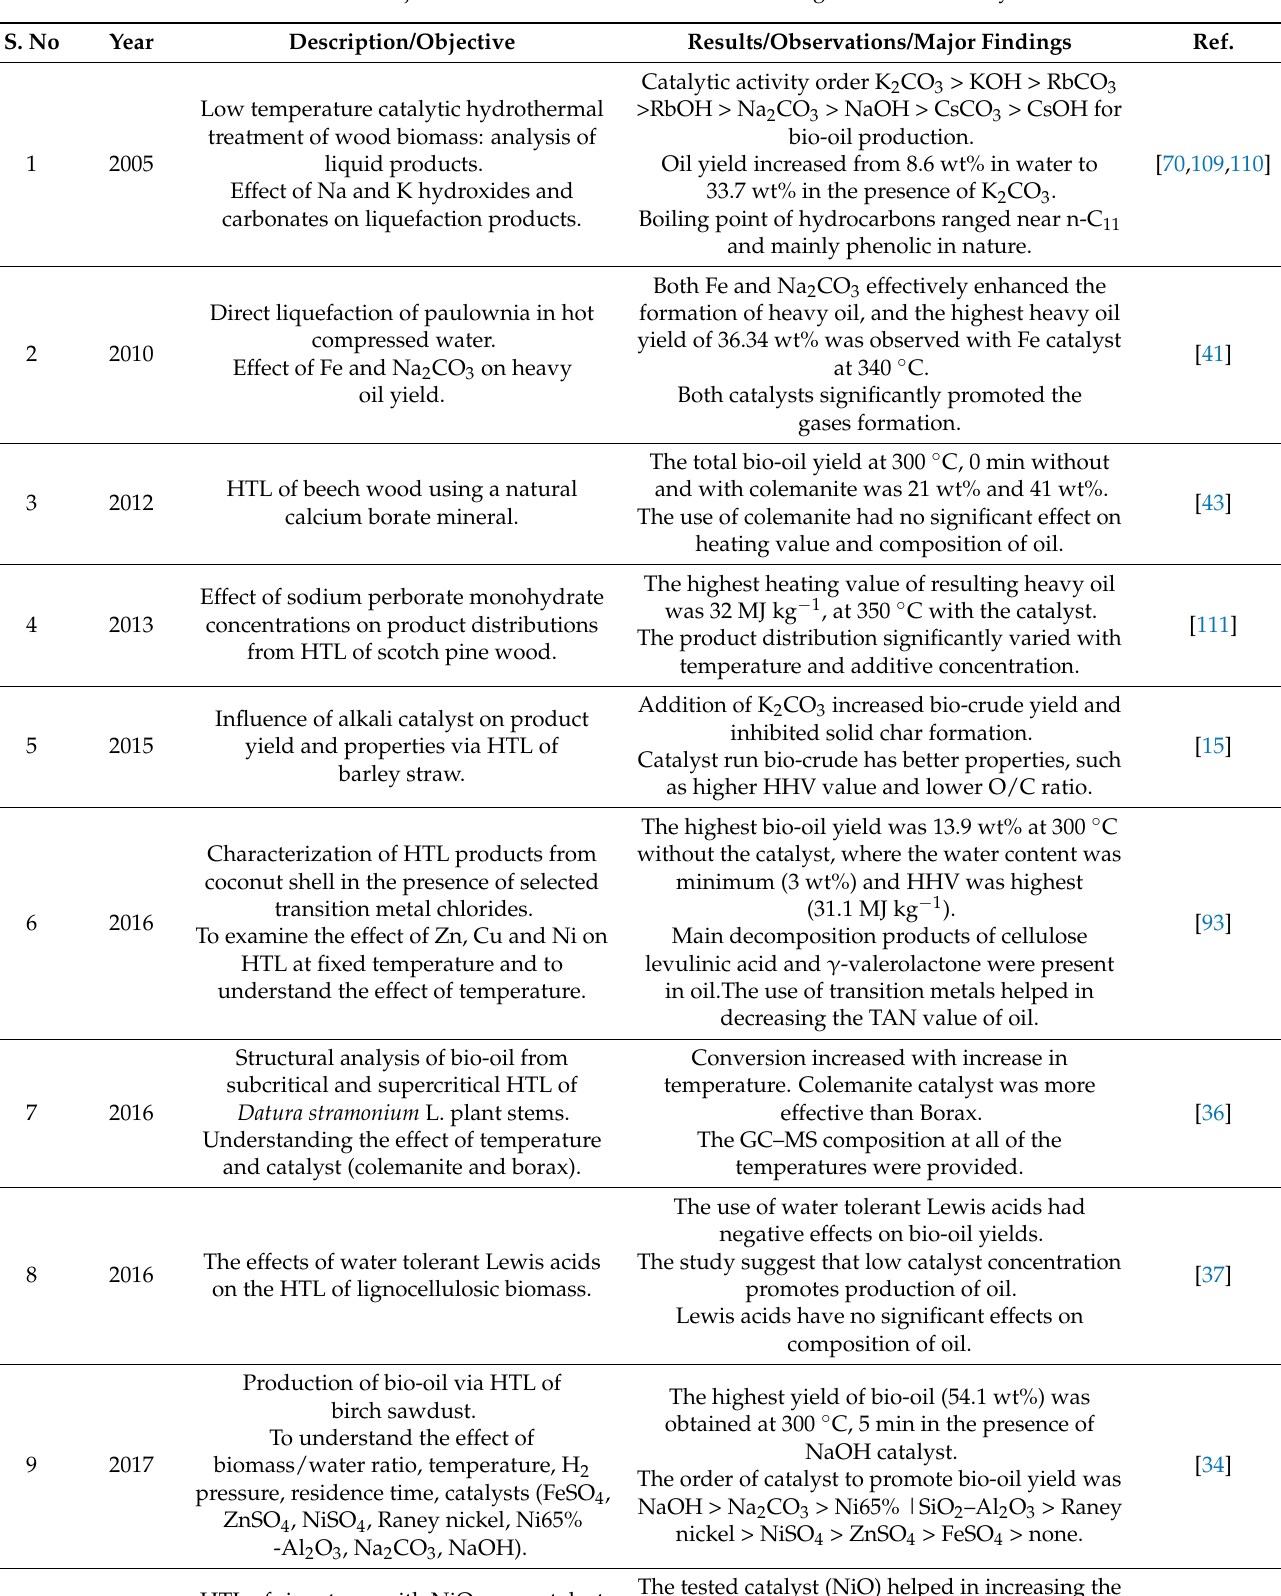
Table 8. Some major HTL studies focused on understanding the effect of catalysts. S.